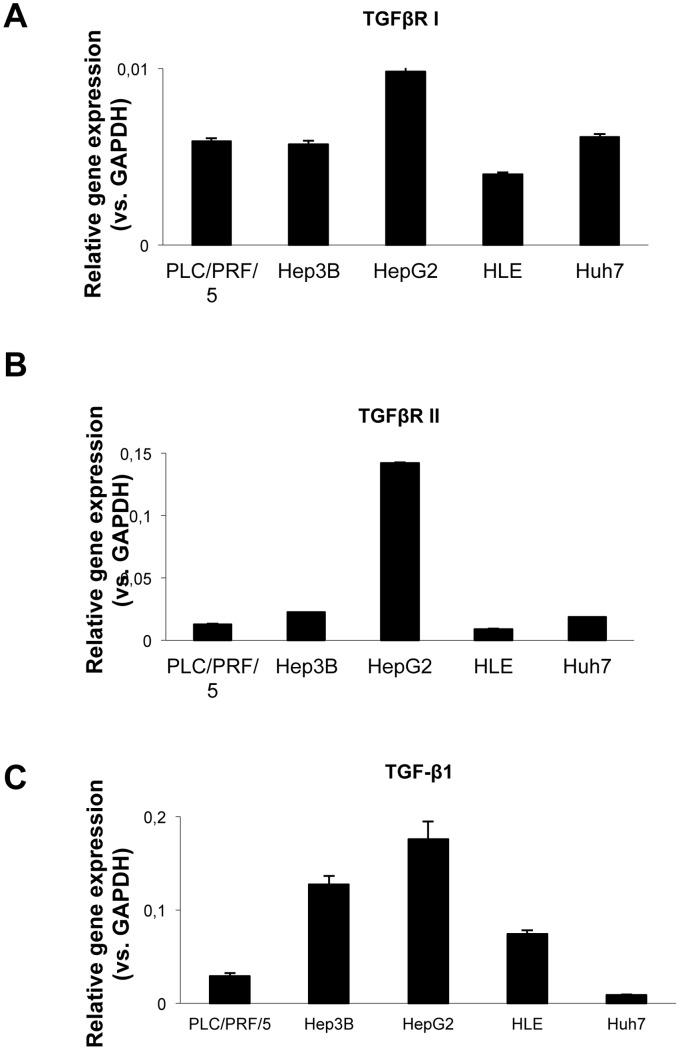
RNA expression levels of TGF-β receptor I, TGF-β receptor II and TGF-β1 in different HCC cell lines evaluated by real-time PCR.Values are expressed as relative gene expression versus GAPDH and represent the mean ±SD of three independent experiments.